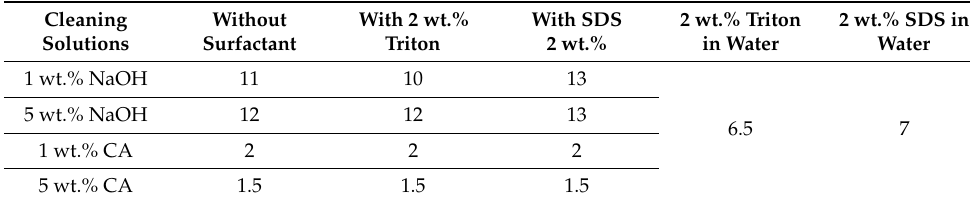
Table 4. pH values of chemical cleaning